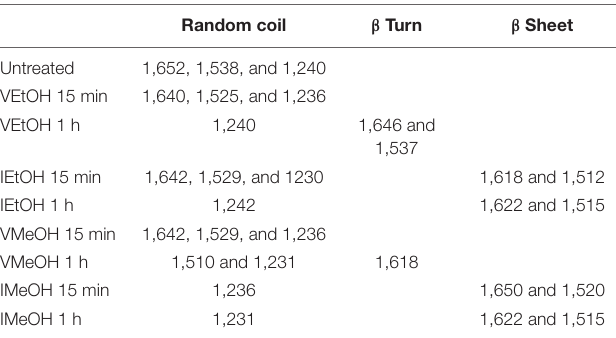
TABLE 1 | Location of the peaks associated with the secondary structures in the SFW samples and the different treatments. Random